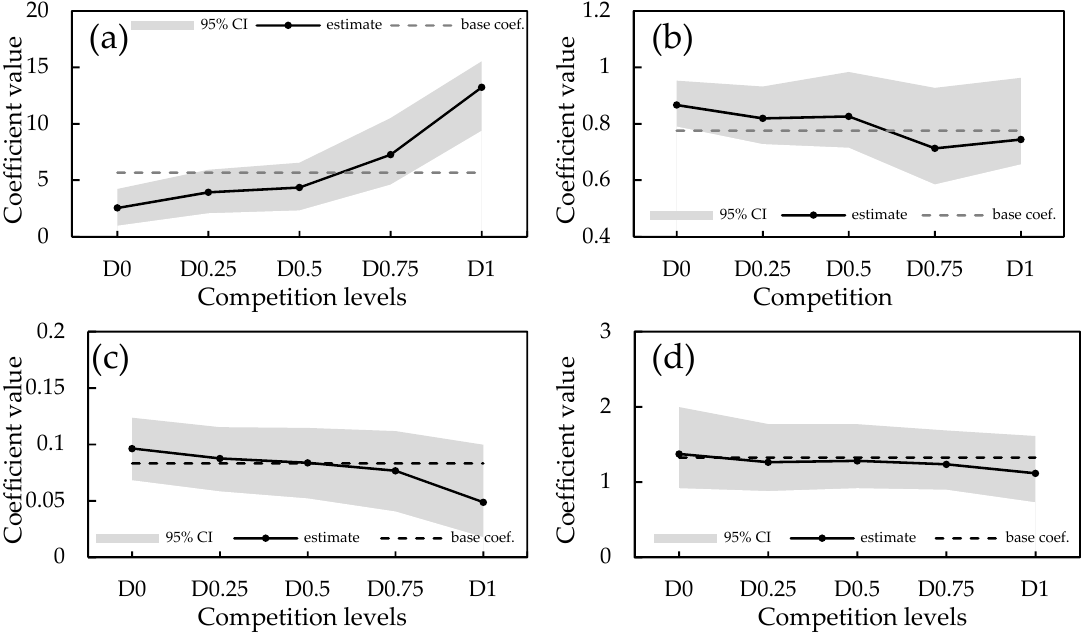
Figure 4. The four coefficient values (a, b, c, d) changing with the competition levels (Figure a – d ). The gray area is 95% confidence interval (CI). The black thin dotted line is the coefficient value of the base model.